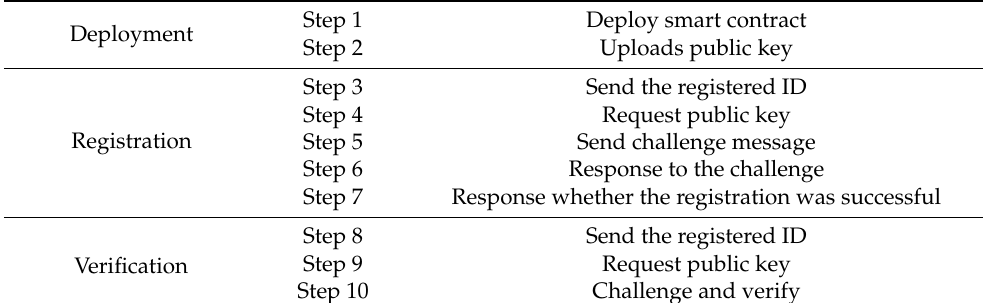
Table 2. Registration and validation steps for existing models.